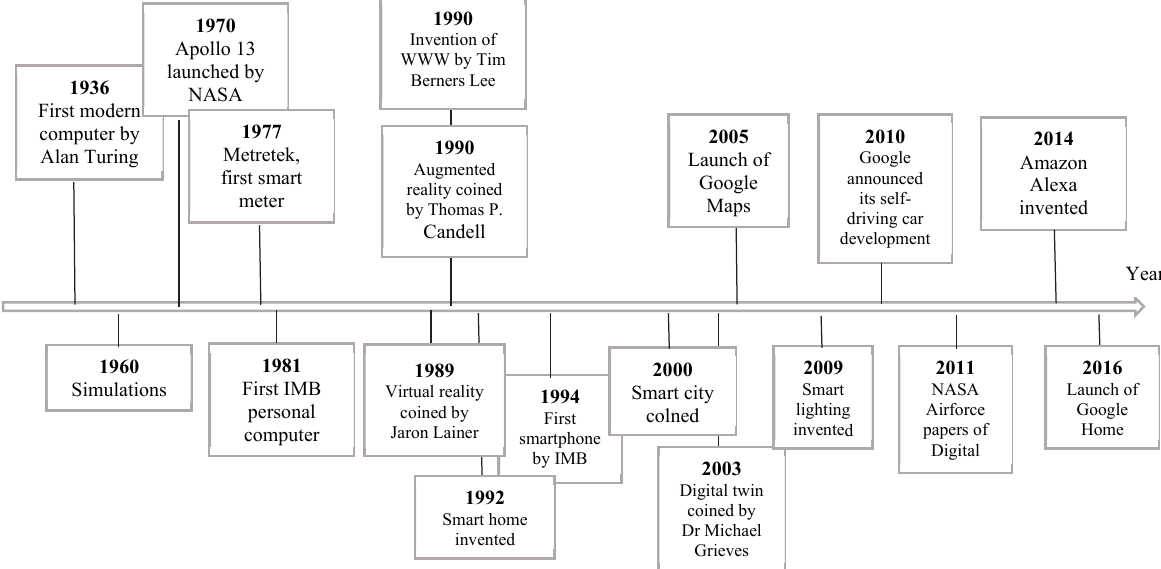
Fig. 1. The evolution of digital transformation and the development of digital